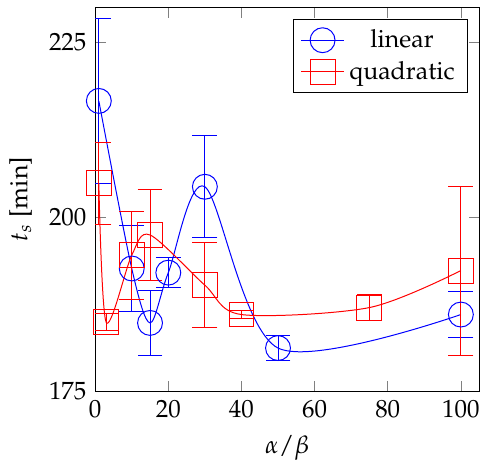
Figure 3. Influence of the load balancing strategy on the simulation time for the packing case. Error bars show standard